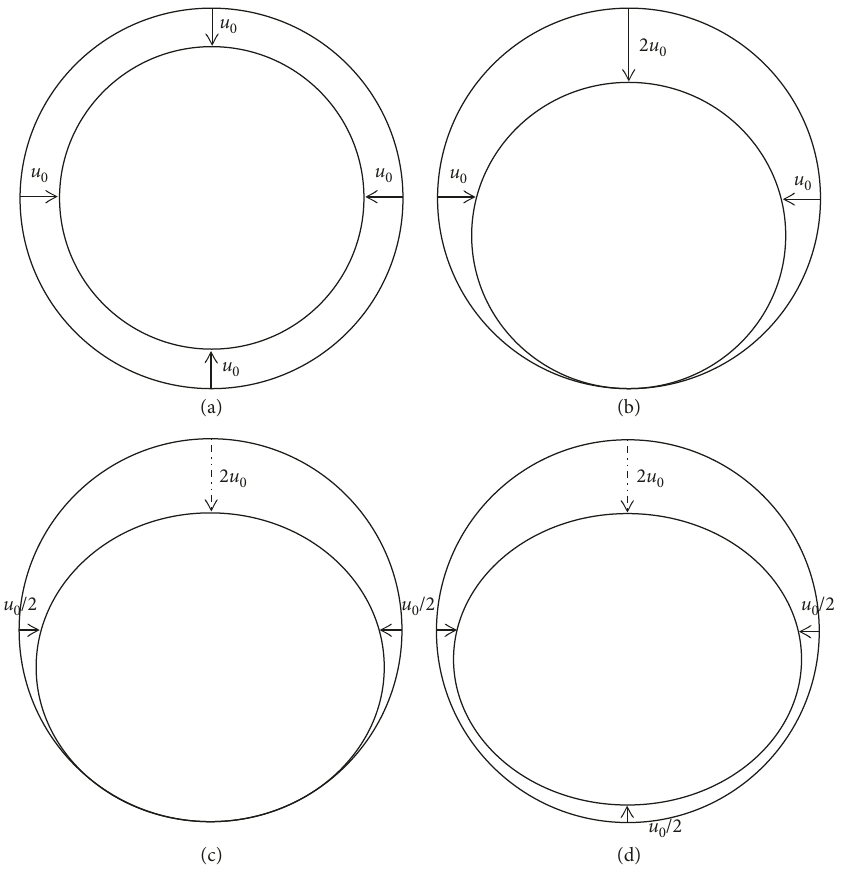
Figure 8: Boundary conditions of shallow tunnels [10]. (a) B.C.-1; (b) B.C.-2; (c) B.C.-3; (d)